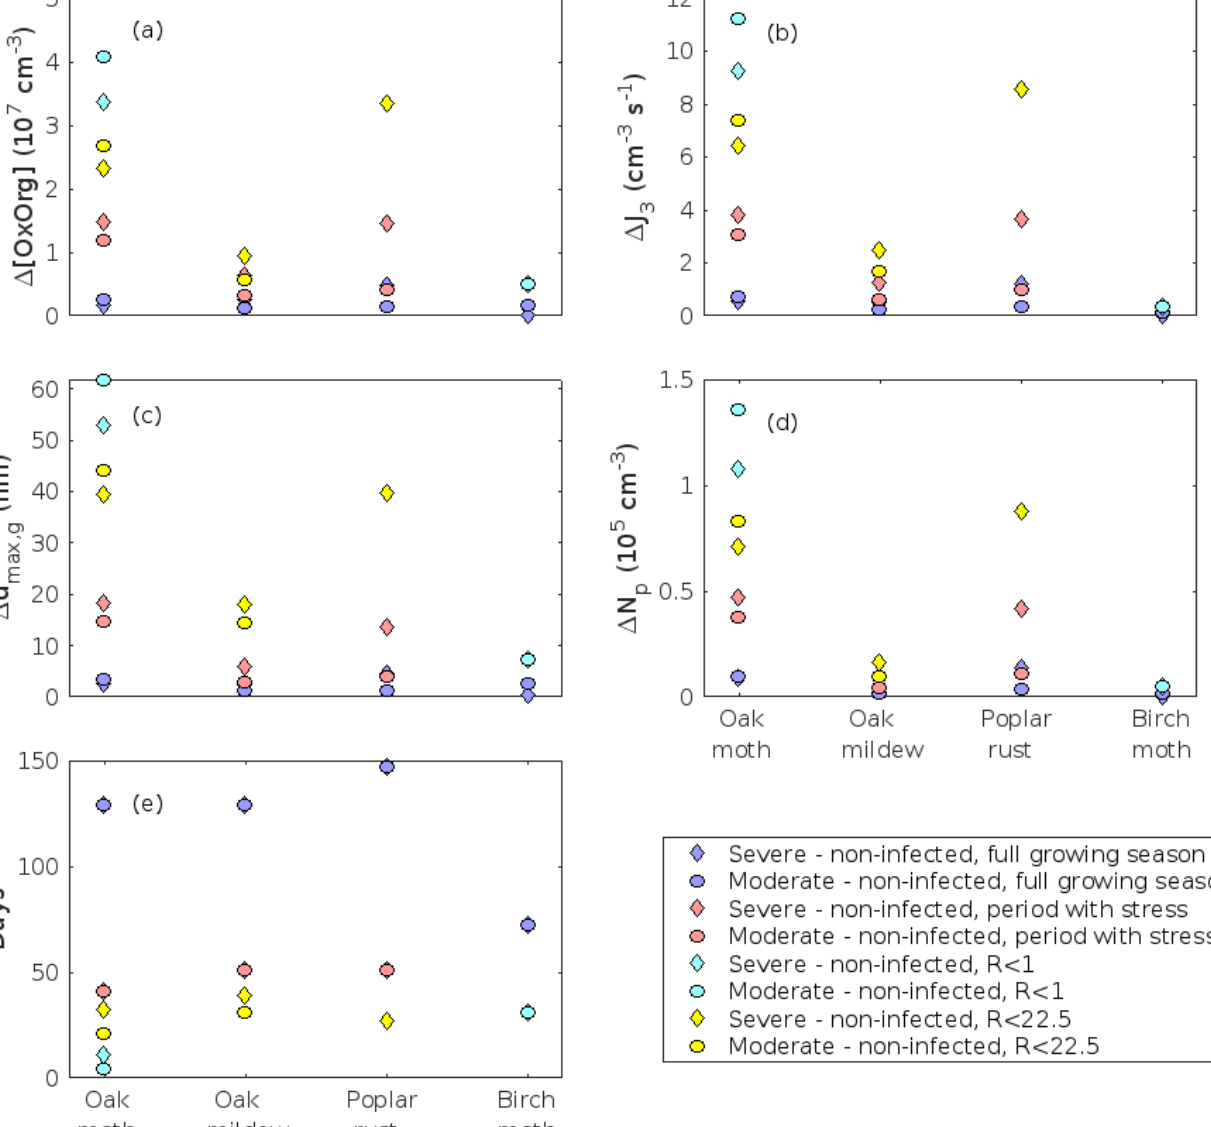
Figure 12. Differences in atmospheric response from various non-infected and biotically stressed plant species. (a) Atmospheric concentra- tions of OxOrg, (b) formation rates of 3nm particles, (c) daily maximum diameter of the growing particle mode, (d) number concentration of formed particles, and (e) amount of days considered. Panels (a) – (d) are provided as the differences between the averaged parameter in a stressed and stress-free forest stand of the same plant species type. Differences and averages are considered based on the complete growing season, the period with stress, when the ratio of isoprene-to-monoterpenes carbon concentration is less than 1 or less than 22.5. Be aware that R is always zero in simulations of birch. In cases where R does not reach less than 1 or less than 22.5 in the atmosphere surrounding a non-infected forest stand but does in the case of the corresponding stressed stand, it is assumed that the atmospheric parameter in the non- infected stand is zero, and hence the difference is given as the value of the stressed stand. The concentration differences of OxOrg, formation rates, and number concentrations are calculated based on an average, for the period of interest, of the median values during 10:00–16:00LT. “Severe” and “moderate” refer to 80% or 30% of the total leaf area having been consumed or infected by the end of the feeding or infection period, respectively. Southern Germany has been used as border conditions for simulations of oak and poplar, while SMEAR I (Finnish Lapland) has been used for modelling of